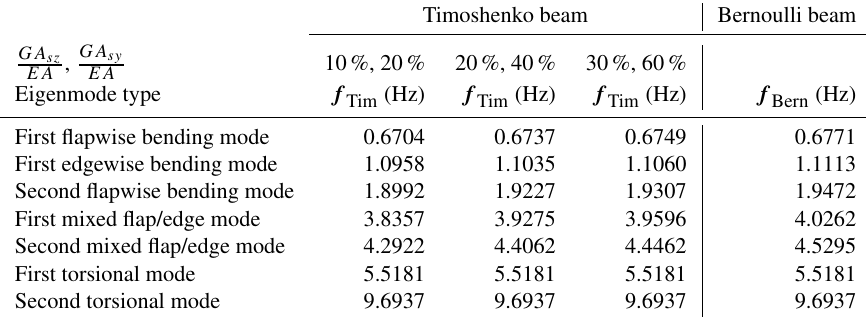
Table 2. Comparison between Timoshenko and Bernoulli beams with three variants for shear stiffness